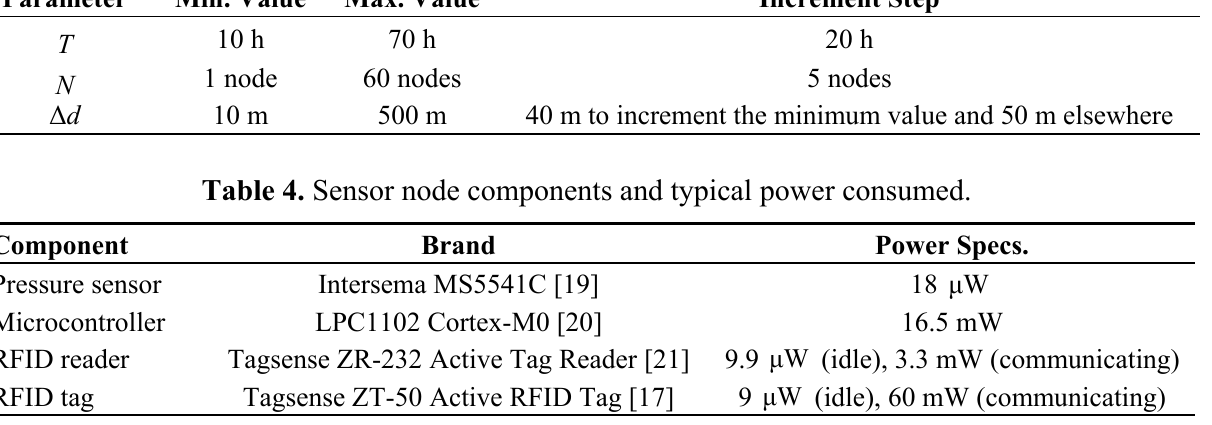
Table 3. Analysis data ( D = 400 km, T